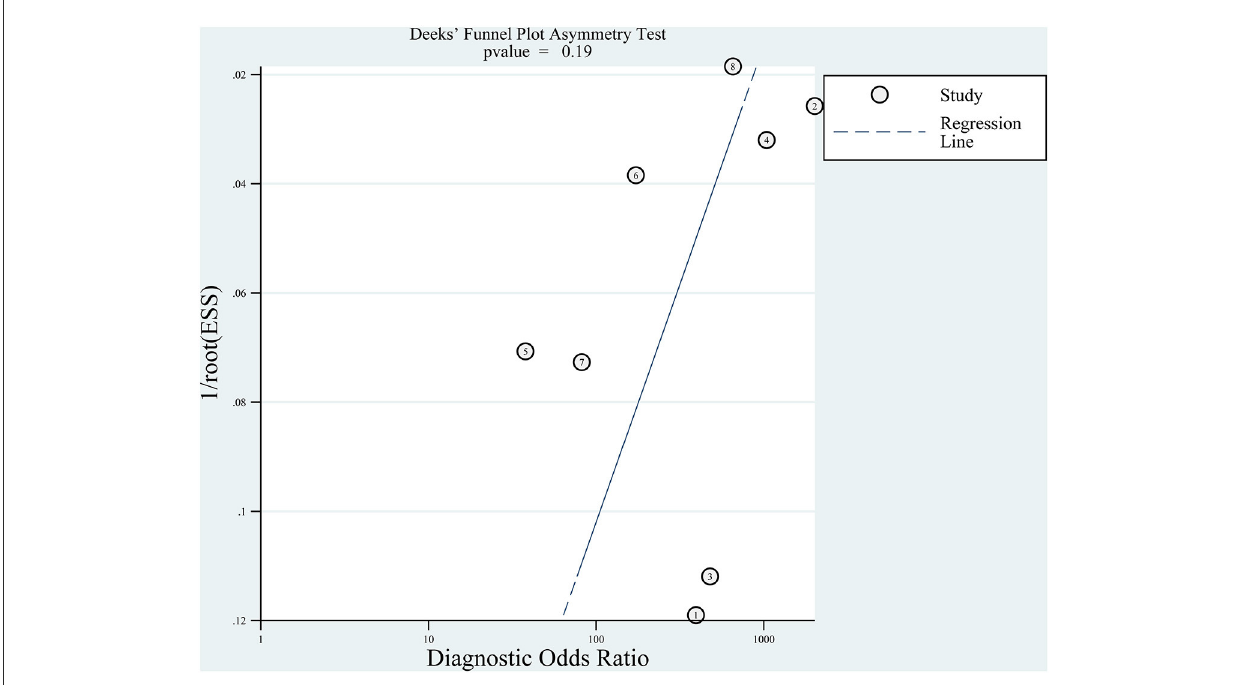
FIGURE8 Deeks’ funnel plot asymmetry test for publication.